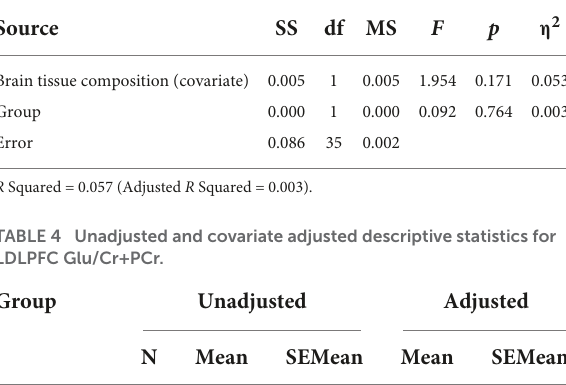
TABLE 3 Analysis of covariance for LDLPFC GABA+/Cr+PCr by group with brain tissue composition as a function of age (Age, LDLPFC %GM and LDLPFC %WM) as covariates.